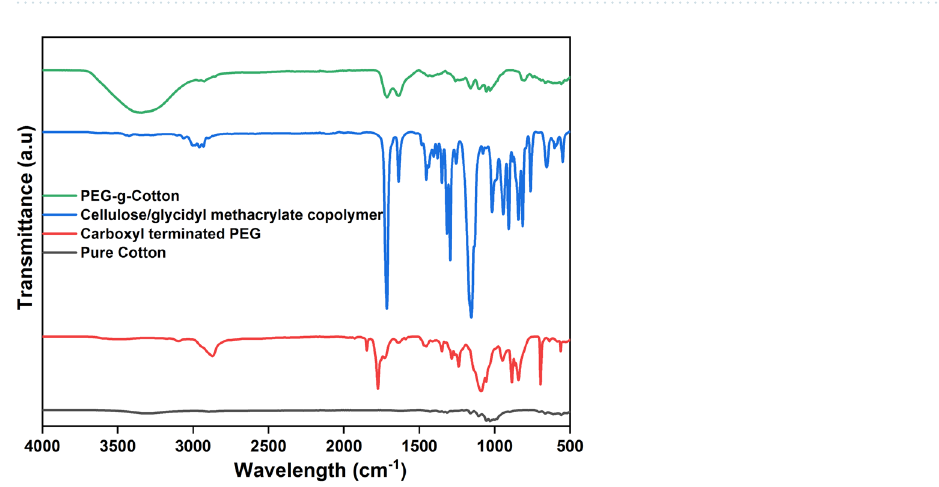
Figure 1. ( a ) XRD of PEG and GO, ( b ) Raman spectrum of PEG and GO, ( c ) FE-SEM of GO, and ( d ) TEM of GO.